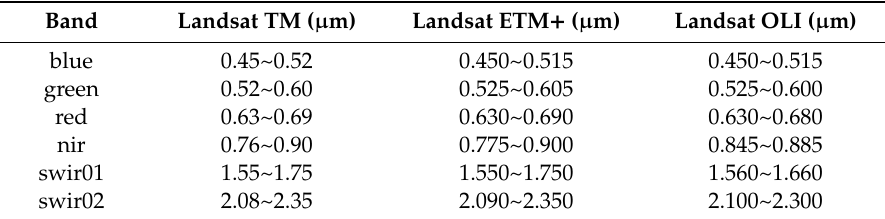
Table 4. Summary of the spectral ranges of Landsat TM, ETM + and